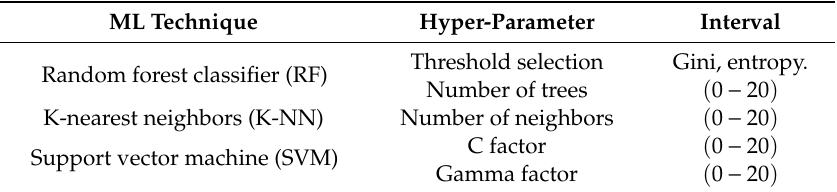
Table 4. Machine learning (ML) techniques and